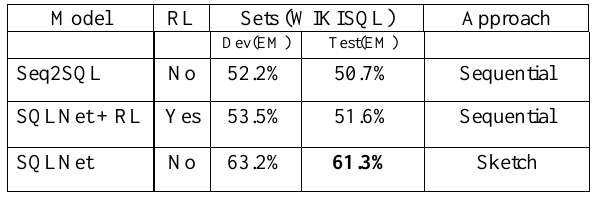
Table 1. Performence of Seq2SQL vs SQLNet